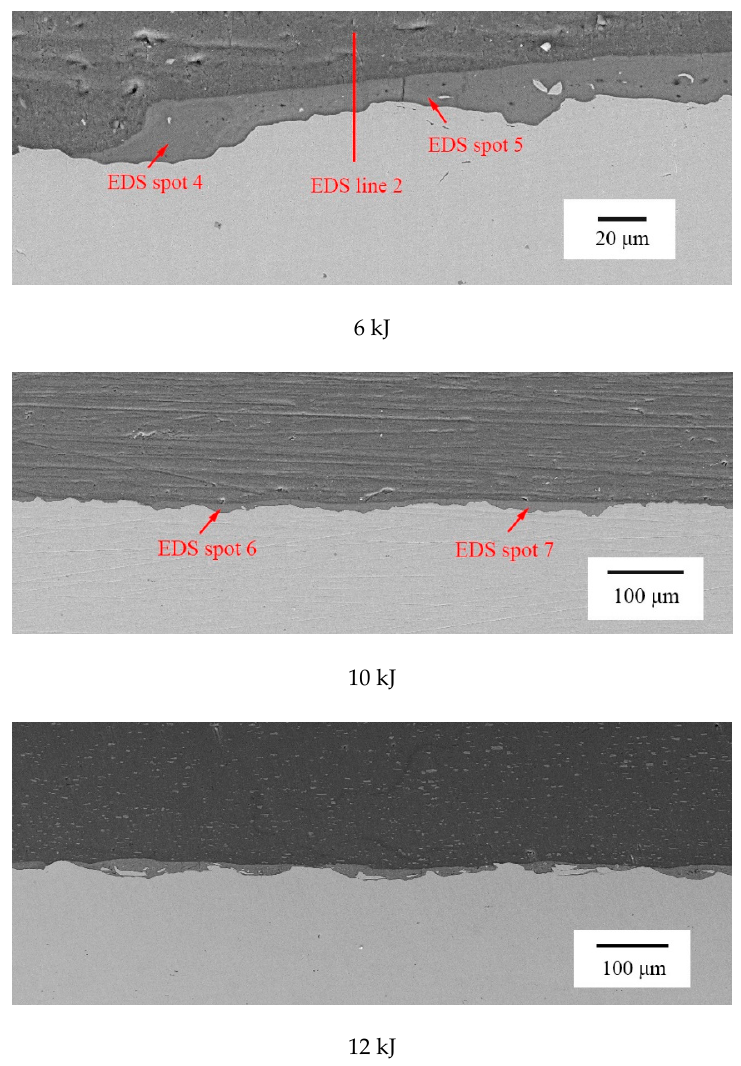
Figure 9. Interface morphologies of 3003 aluminium and 321 stainless steel at 8 kJ energy input. ( a ) unwelded area. ( b ) IMC bonding area. ( c ) Mechanical-clinch area.